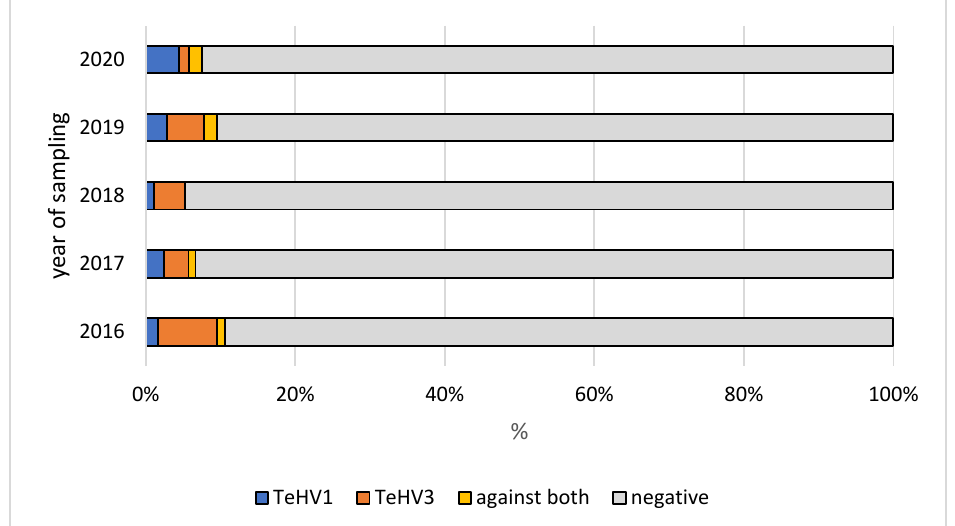
Figure 4. Herpesvirus (TeHV1 and TeHV3) antibody detection rates (titer 2 or higher) in five Testudo species (Hermann’s tortoises, Testudo hermanni ; spur-thighed tortoises, Testudo graeca ; marginated tortoises, Testudo marginata ; Russian tortoises, Testudo horsfieldii ; and Egyptian tortoises, Testudo kleinmanni ) for the different years of sampling.